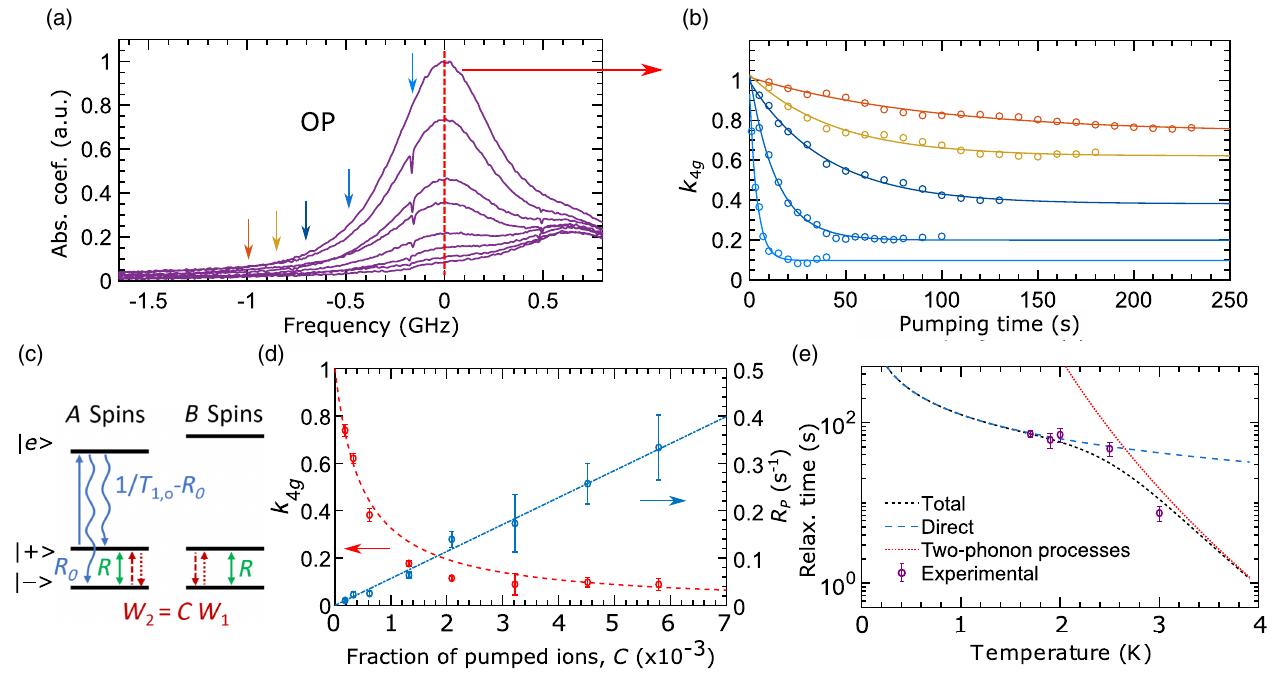
FIG. 2. Dynamics of DEOP and spin-lattice relaxation. (a) Absorption profile around the j 4 g i ↔ j 1 e i transition after 0 s, 1 s, 3 s, 5 s, 7 s, 10 s, 30 s, and 40 s of OP at − 0 . 17 GHz (light blue arrow). The whole inhomogeneously broadened absorption decreases when pumping duration increases. The laser creates a narrow spectral hole at − 0 . 17 GHz, which is clearly seen for pump duration between 1 and 7 s. The small side hole at þ 0 . 5 GHz originates from the j 3 g i level and should therefore appear as an antihole. This is explained by a fast relaxation between the j 4 g i and j 3 g i levels by flip-flop processes [32]. The absorption centered at þ 0 . 655 MHz corresponds to the j 3 g i ↔ j 1 e i transition. (b) Normalized level j 4 g i population k 4 g as a function of OP duration for different laser frequencies shown in panel (a) by color-coded arrows. Solid lines are exponential fits to the data (see text). (c) Spin- 1 = 2 model scheme (see text). (d) Level j 4 g i normalized steady-state populations ( k ∞ 4 g , red circles) and polarization rate ( R P , blue circles) as a function of the fraction of pumped ions (see text). Solid lines correspond to fits using a spin- 1 = 2 model and rate equations. (e) Relaxation time 1 =R as a function of c temperature deduced from absorption recovery after OP is stopped. The lines are fits using direct and two-phonon processes (see text). All error bars correspond to a 95% confidence